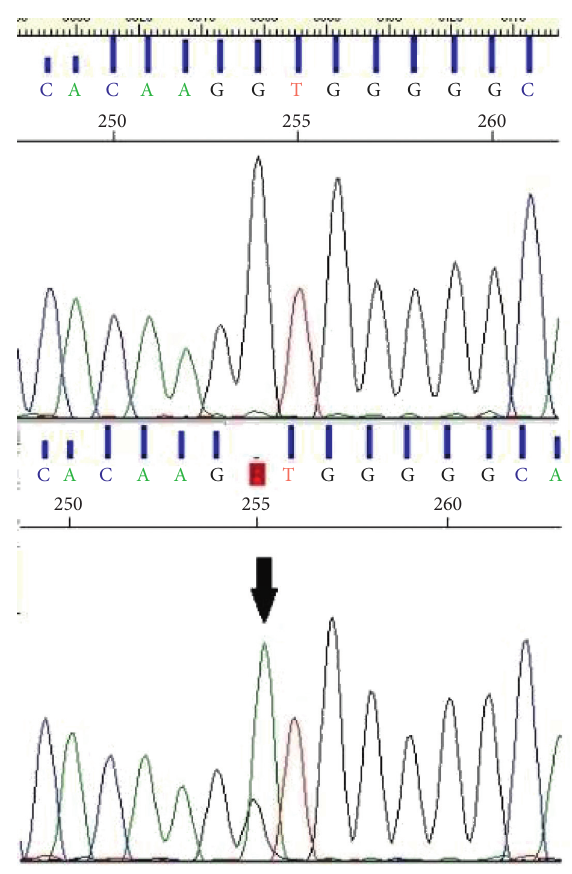
Figure 1: Electropherograms showing the splicing pathogenic variant G > A (arrow). On the top: germline DNA; on the bottom: somatic